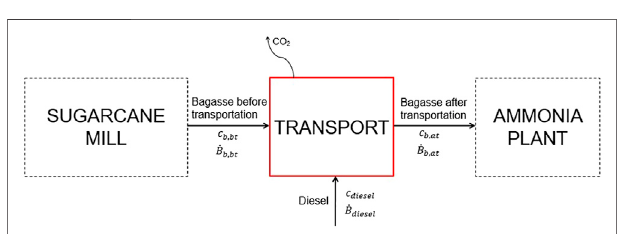
FIGURE 4 | Control volume of the transportation stage of the residual